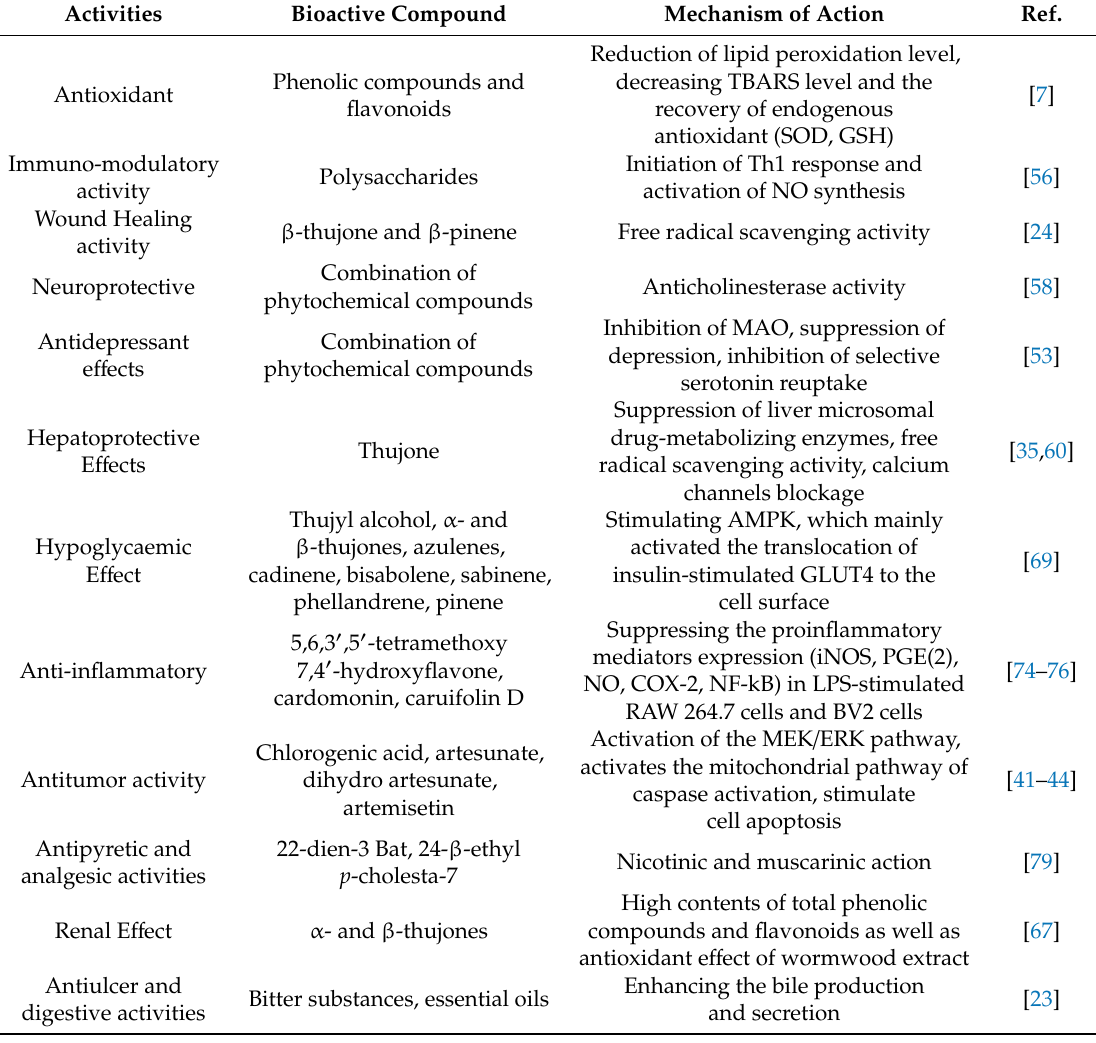
Table 4. The pharmacological activity of A. absinthium and its related